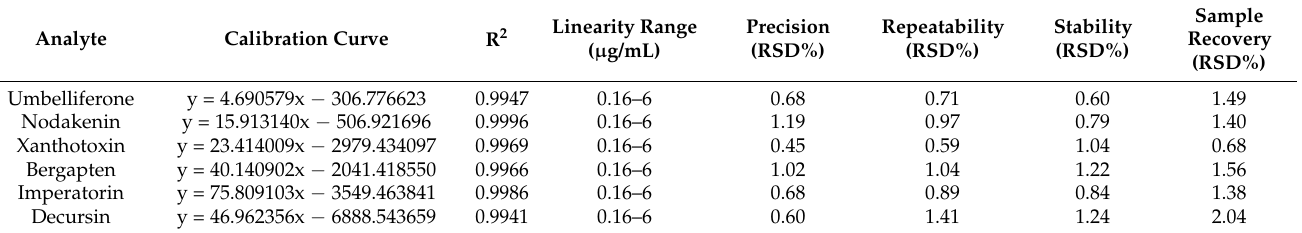
Table 6. Validation of linear regression equation, linear range, precision, repeatability and stability of 6 coumarins .